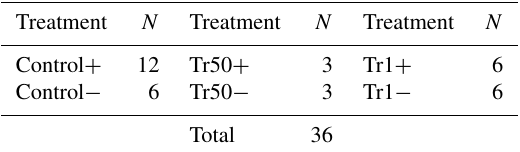
Table 2. Number ( N ) of measured experimental plots on the differ- ent trenching treatments (Control: soil was non-trenched, Tr50: the ingrowth of mycorrhizal fungi was allowed, and Tr1: decomposers were the only source) with vegetation ( + ) and those with bare soil ( − ) and the total number of